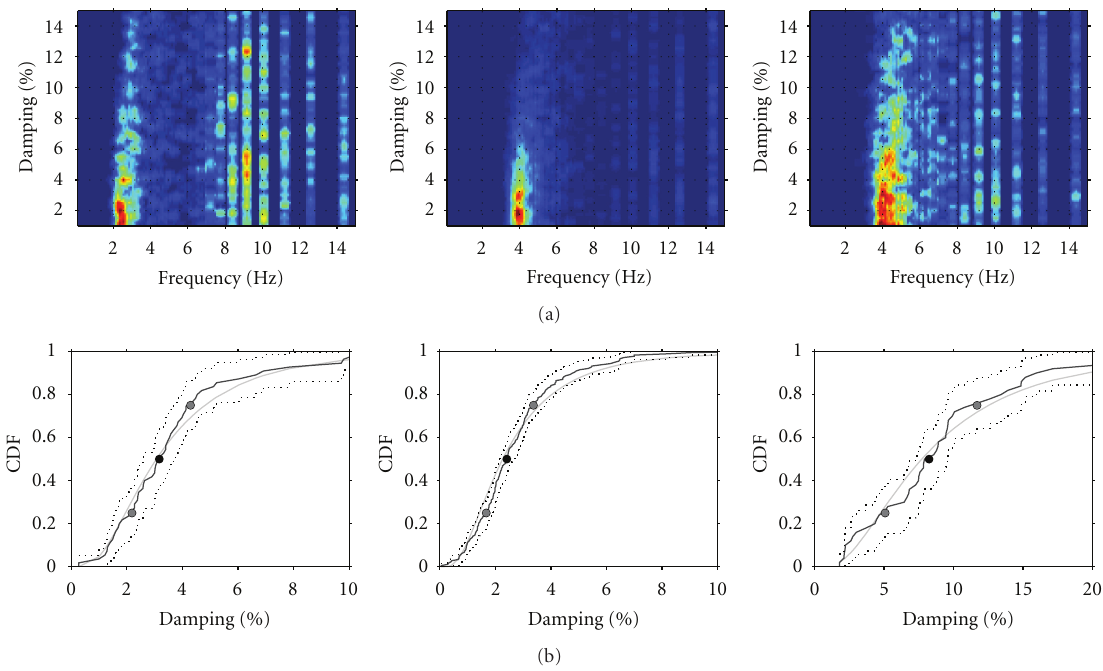
Figure 12: (a) Histograms (binned frequency and damping) derived using the NonPaDAn approach for sensor 5 for the transversal (left panel), longitudinal (central panel), and vertical (right panel) components. (b) Same order as (a), but showing the CDFs of the damping estimated for the fundamental frequency. More details are provided in the